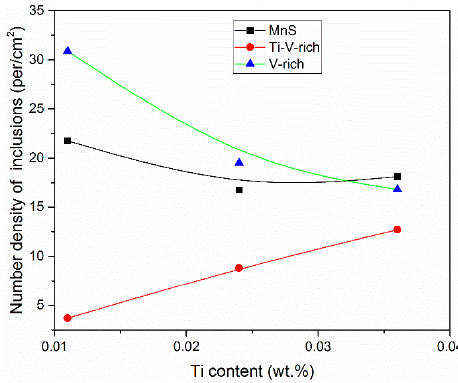
Figure 5. Variation of the number density of the inclusions in samples with the Ti content.